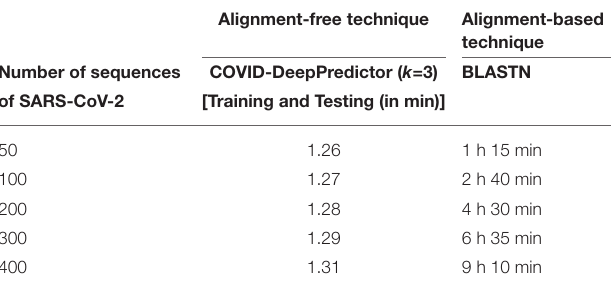
TABLE 4 | Runtime comparison of COVID-DeepPredictor and BLASTN. Alignment-free